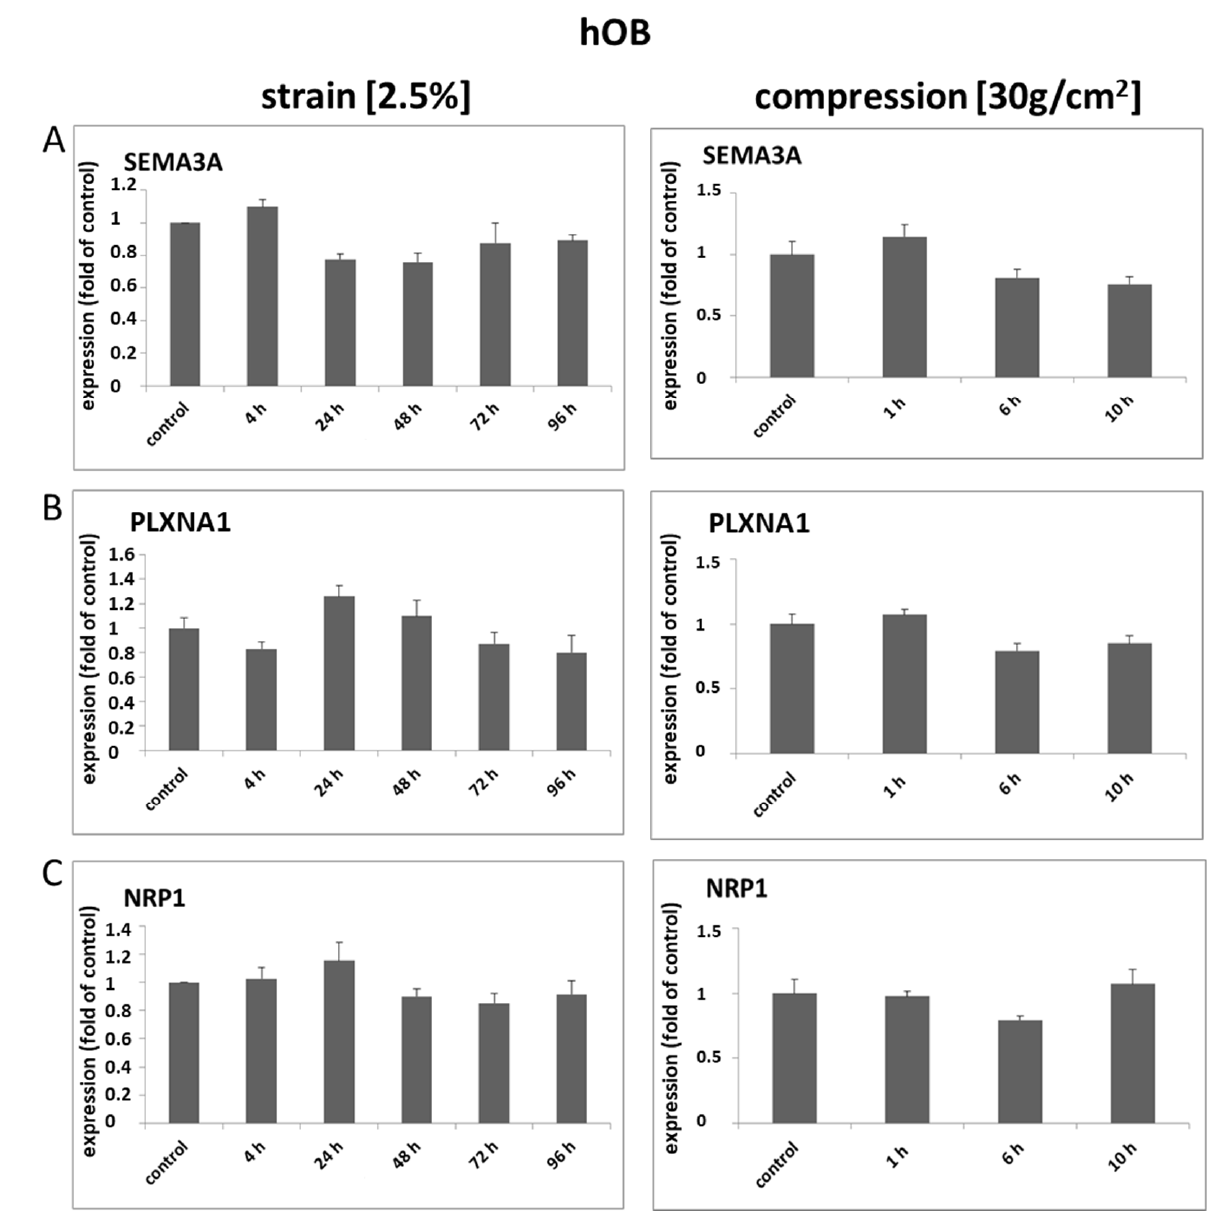
Figure 3. SEMA3A, PLXNA1 and NRP1 show no significant mechanically induced expression changes in osteoblasts of the alveolar bone. Three independent populations of primary human osteoblasts of alveolar bones were either strained (2.5%) or compressed (30 g/cm 2 ) for the indicated periods of time. Neither strain nor compression had significant effects on the expressions of SEMA3A ( A ), PLXNA1 ( B ) and NRP1 ( C ). Untreated cells served as controls. Quantitative RT-PCR experiments were carried out in triplicates. Cumulative data of the three cell populations data are given as mean ± SD. * = p < 0.05 vs. control (Kruskal–Wallis one-way analysis of variance on ranks (ANOVA), followed by Dunn’s post-hoc test).